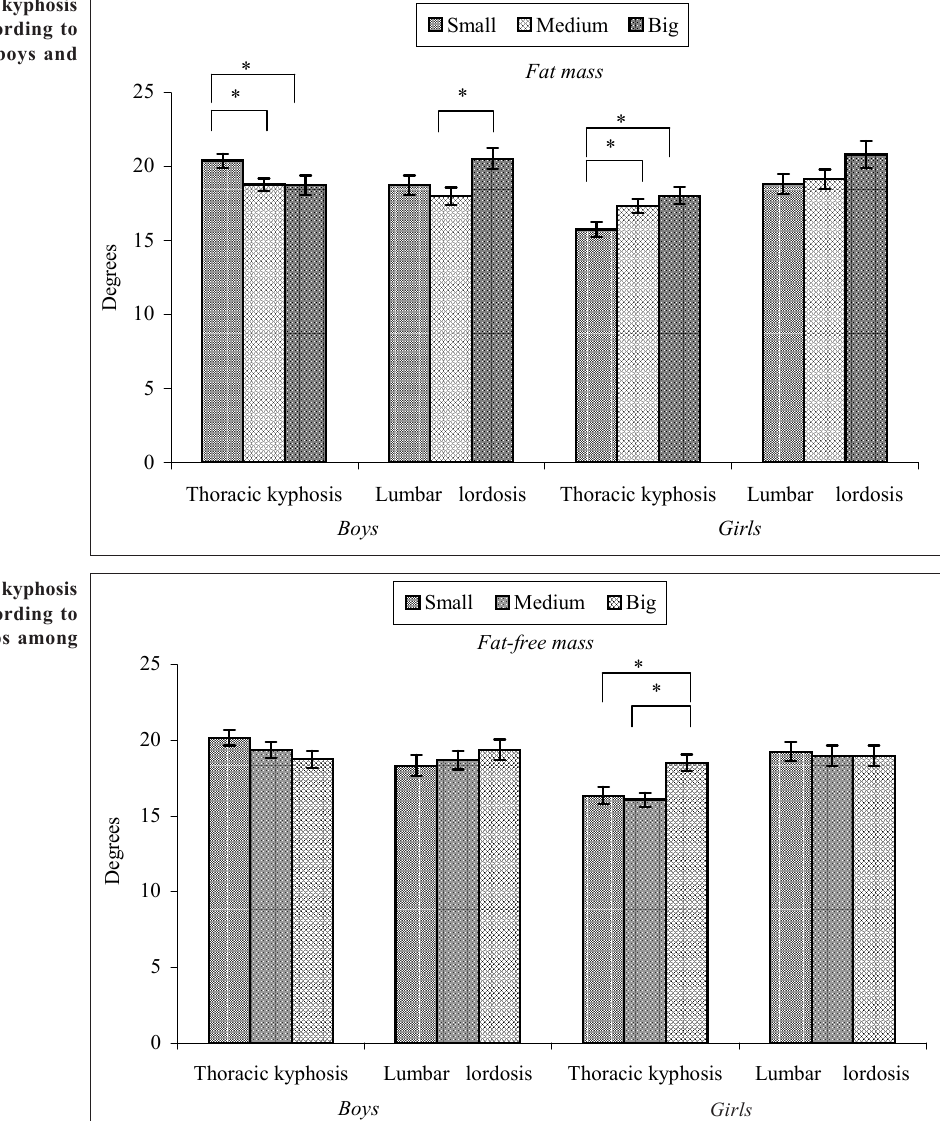
anthropometric and spine’s sagittal profile